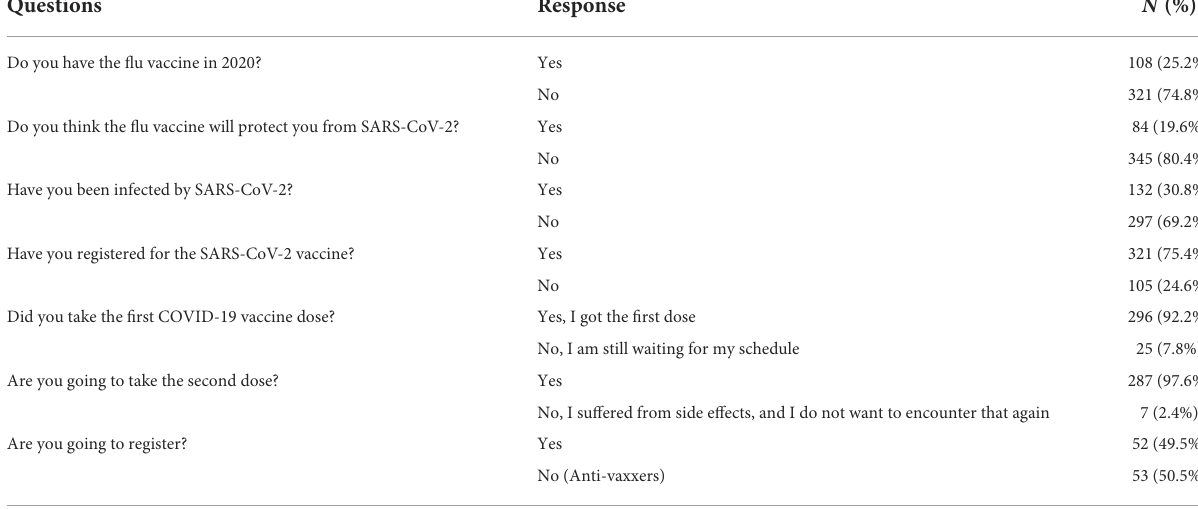
TABLE 2 Questions that reflect patients’ attitudes toward SARS-CoV-2 vaccines.